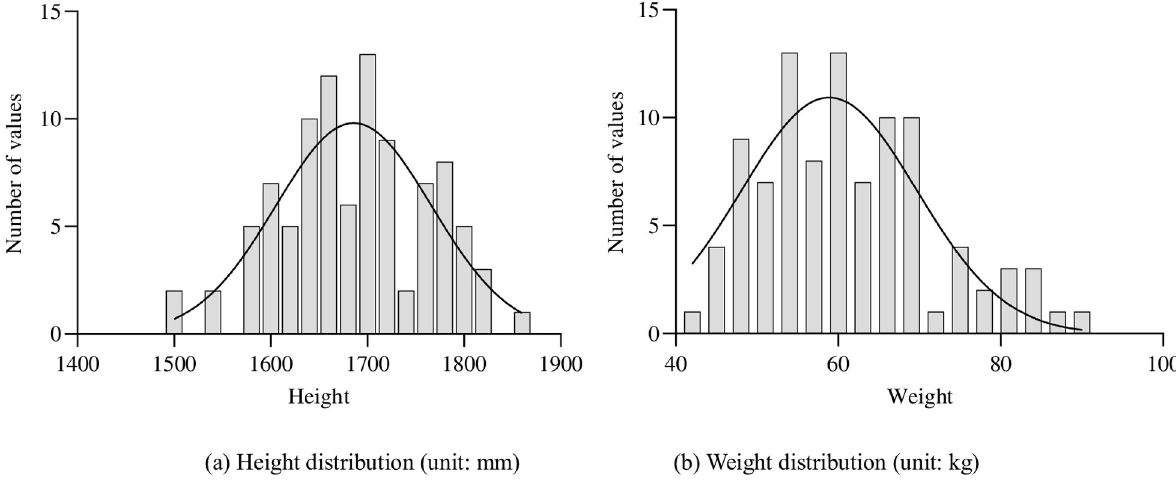
Fig 3. Histogram of subject’s height and weight distribution. (a) Height distribution (unit: mm) and (b) Weight distribution (unit: kg).